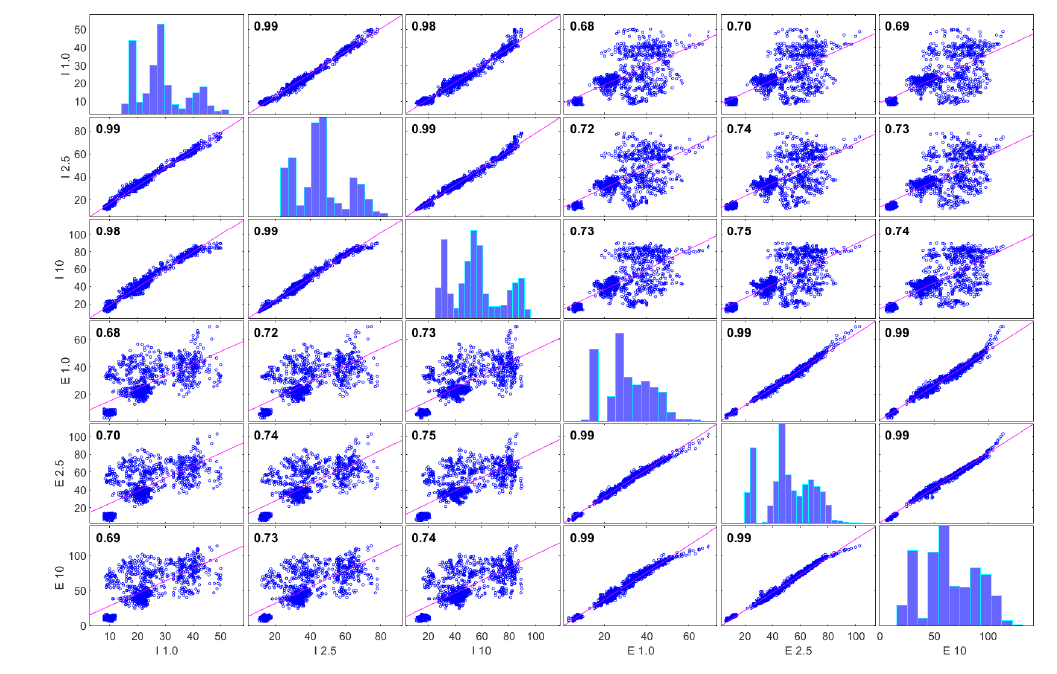
Figure 9. Histogram and correlation of measured PM concentrations without pollution